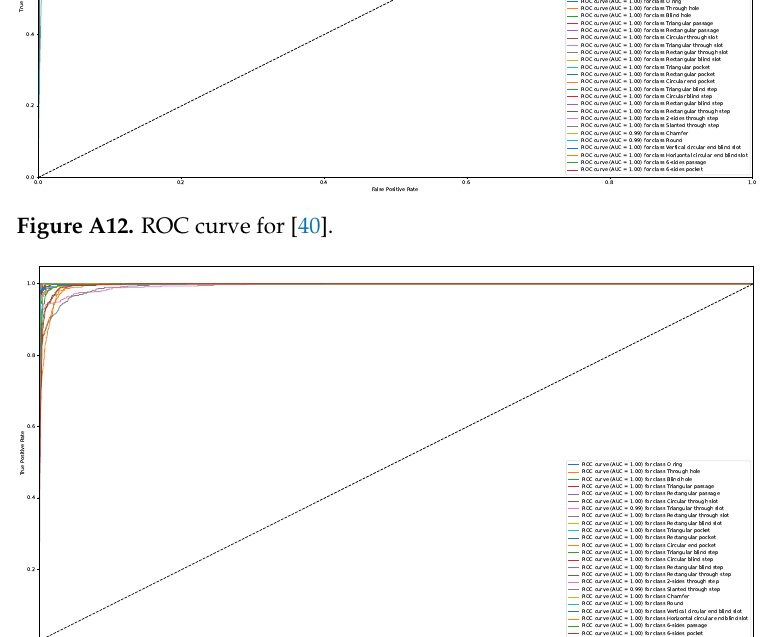
curve (AUC = 0.99) for class Triangular through slotROC curve (AUC = 1.00) for class Rectangular through slotROC curve (AUC = 1.00) for class Rectangular blind slotROC curve (AUC = 1.00) for class Triangular pocketROC curve (AUC = 1.00) for class Rectangular pocketROC curve (AUC = 1.00) for class Circular end pocketROC curve (AUC = 1.00) for class Triangular blind stepROC curve (AUC = 1.00) for class Circular blind stepROC curve (AUC = 1.00) for class Rectangular blind stepROC curve (AUC = 1.00) for class Rectangular through stepROC curve (AUC = 1.00) for class 2-sides through stepROC curve (AUC = 0.99) for class Slanted through stepROC curve (AUC = 1.00) for class ChamferROC curve (AUC = 1.00) for class RoundROC curve (AUC = 1.00) for class Vertical circular end blind slotROC curve (AUC = 1.00) for class Horizontal circular end blind slotROC curve (AUC = 1.00) for class 6-sides passageROC curve (AUC = 1.00) for class 6-sides pocket